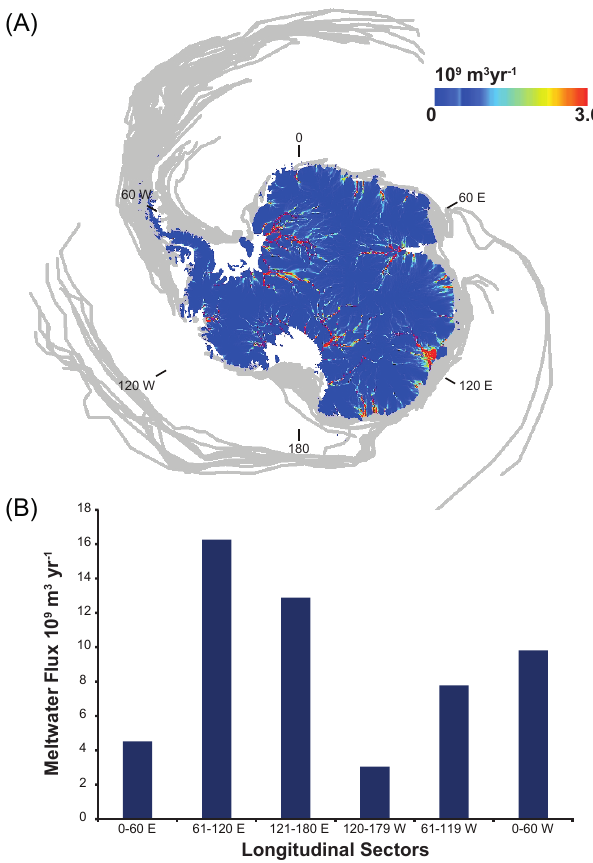
Figure 1. (a) Distribution of ice-sheet-derived iron fluxes show- ing modelled subglacial meltwater fluxes and iceberg tracks from the Antarctic Ice Sheet. Both of these ice-sheet-derived mass flux distributions are controlled principally by the location of major ice stream complexes and ocean circulation. (b) Regionally integrated coastal subglacial meltwater fluxes indicating which regions around Antarctica are most influenced by subglacial meltwater input.